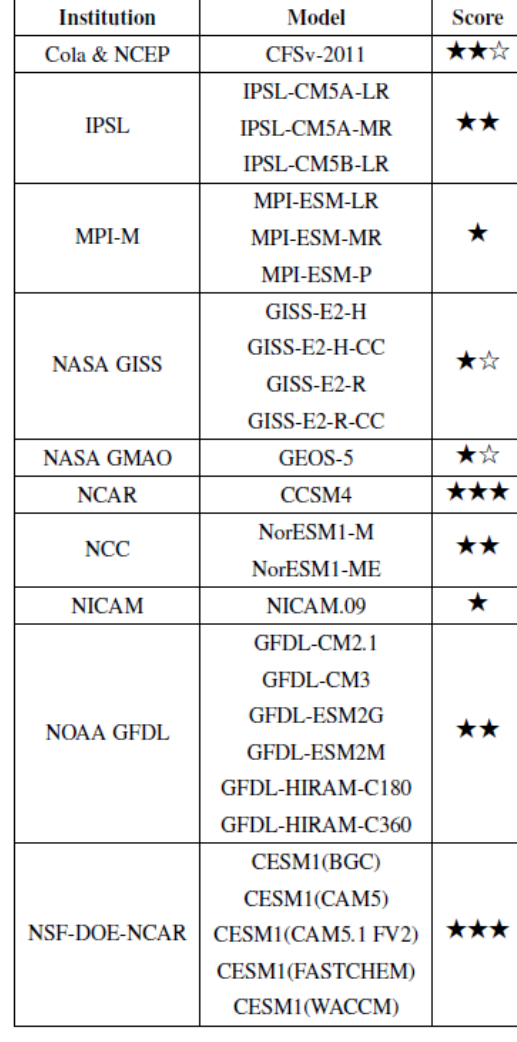
Table 3. CMIP5 models with code obtained and scores of repro- ducibility. The maximum value of three filled stars is given to mod- els that are accessible through the internet without restriction and with a license that allows full testing and evaluation of the model. The score was reduced by one star for each of the following criteria: if in order to gain access to the model we had to contact a research centre or development group, sign license agreements, or identify ourselves as scientists undertaking climate research and according to the rights to evaluate and use the model as granted by the license (if applicable). An unfilled star means that the license of the model does not allow modification of the